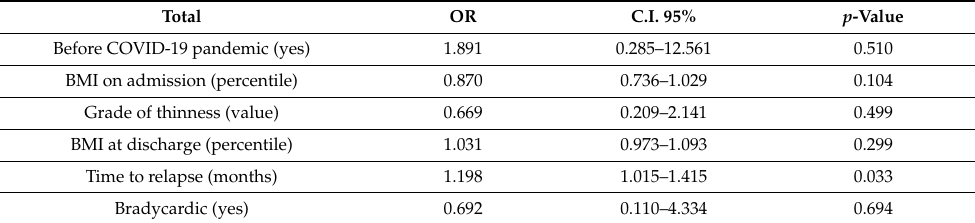
Table 3. Multivariate logistic regression (dependent variable: enteral nutrition administered).